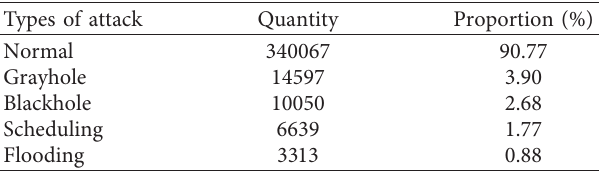
Figure 1: The workflow of developed machine learning and deep learning models. Table 1: Types of attack in WSN